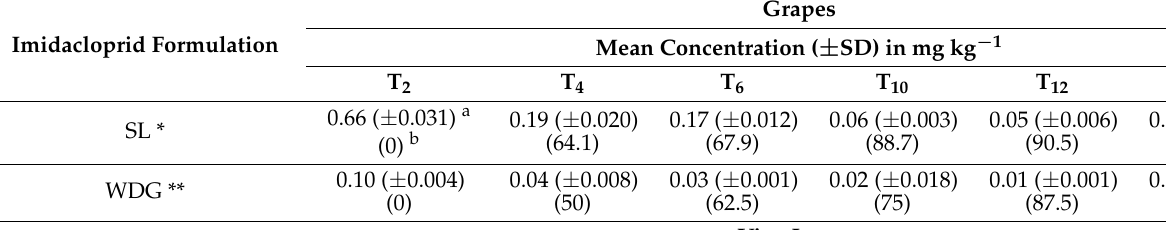
Table 2. Residues of imidacloprid (SL and WDG) in grapes and vine leaves ( n = 5).